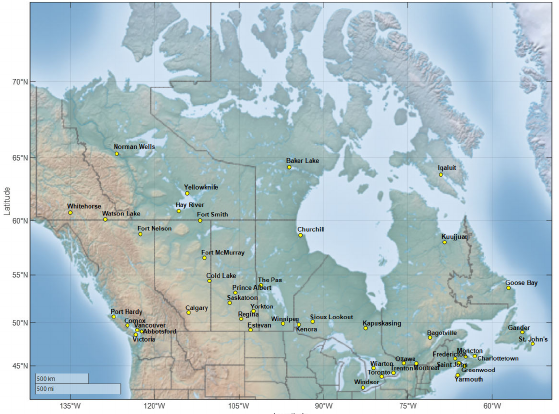
Figure 1. Map of Canada with locations of climate